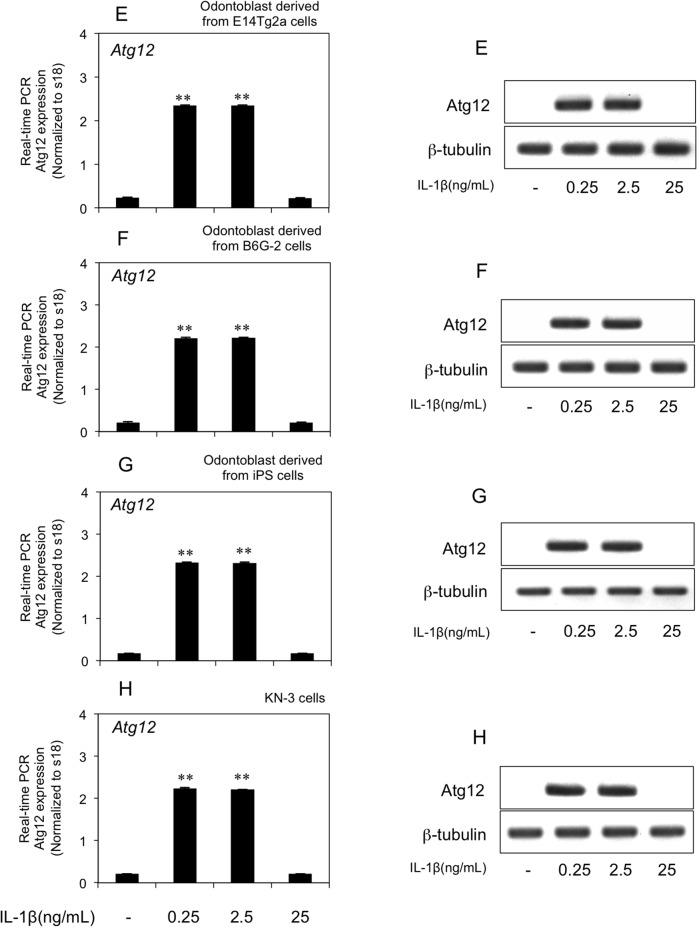
IL-1β-induced expression of Atg12 mRNA and protein in odontoblast-like cells.Two stem cell-derived odontoblast-like cell lines and an odontoblast cell line (KN-3) were treated with IL-1β (0, 0.25, 2.5, and 25 ng/mL). (A–D) qPCR analysis of Atg12 mRNA expression relative to the control (18S rRNA). Data are the means ± SD of four independent experiments. **P < 0.01. (E–H) Western blot analysis of Atg12 and β-tubulin protein levels following stimulation with IL-1β. Representative blots of three independent experiments are shown.